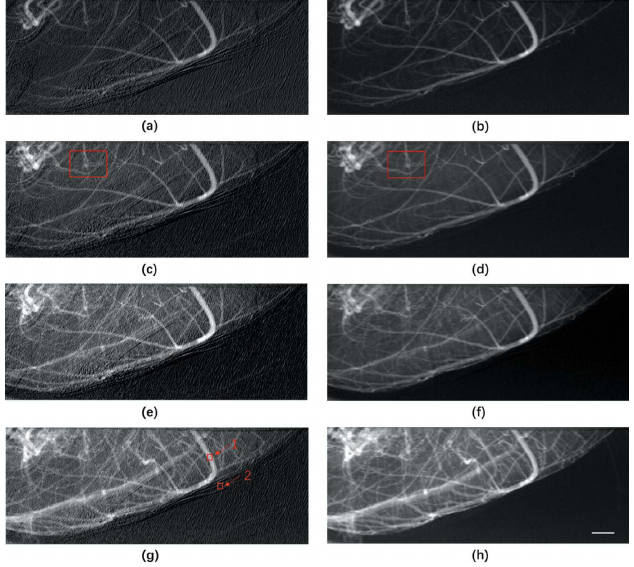
Figure 4 Magnified view of microvessels reconstructed using the temporal subtraction method and PTA, where ( a ) and ( b ) are the areas denoted with a red box in Figs. 3( c ) and 3( d ), respectively. Panels ( c ) and ( d ) are corresponding line profiles at the positions marked by the red dashed lines in ( a ) and ( b ). Scale bar: 200 m